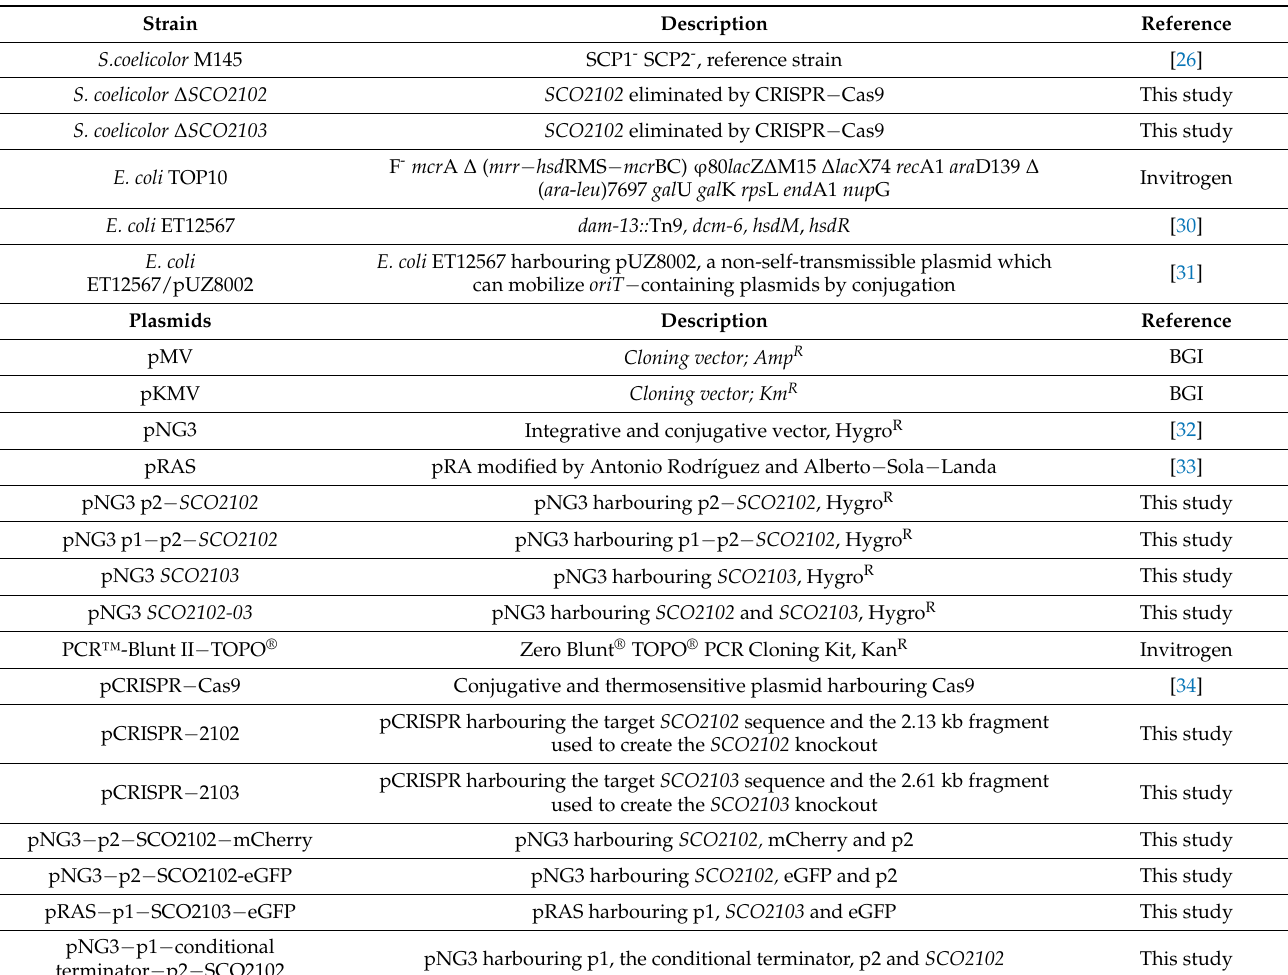
Table 1. Bacterial strains, plasmids and primers used in this